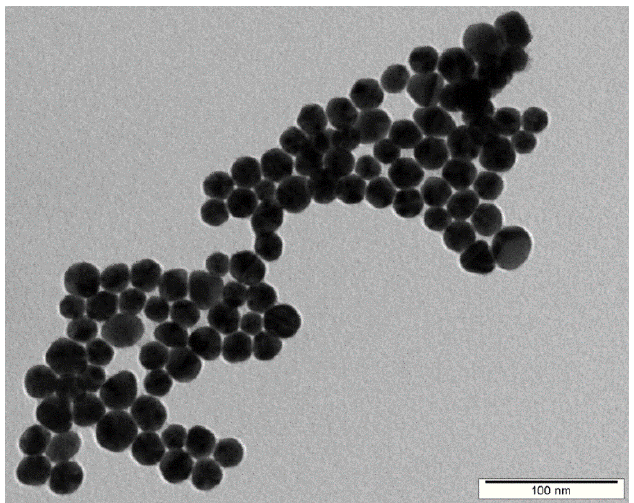
Figure 1. TEM image of as-synthesized AgNPs entering the immobilization process.